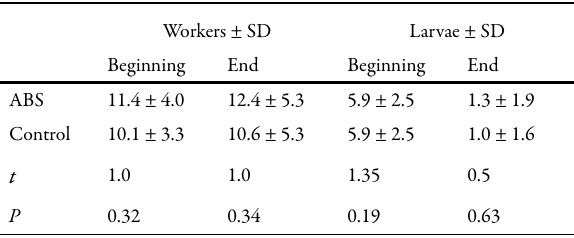
table 1. Mean numbers (± SD) of adult workers and larvae in the aspartame based sweetener colonies (n = 16) and in the control colonies (n = 14). The variances were equal in all tests ( P = 0.46 –0.98). AbS = aspartame-based sweetener